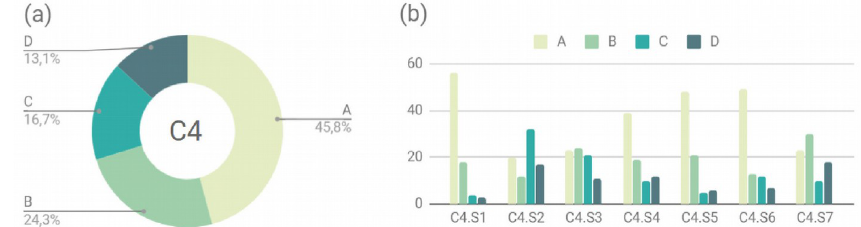
Figure 8. Student assessment of category C4. Teamwork (a) as a whole and (b) for each question. Table 3 shows the coding of the